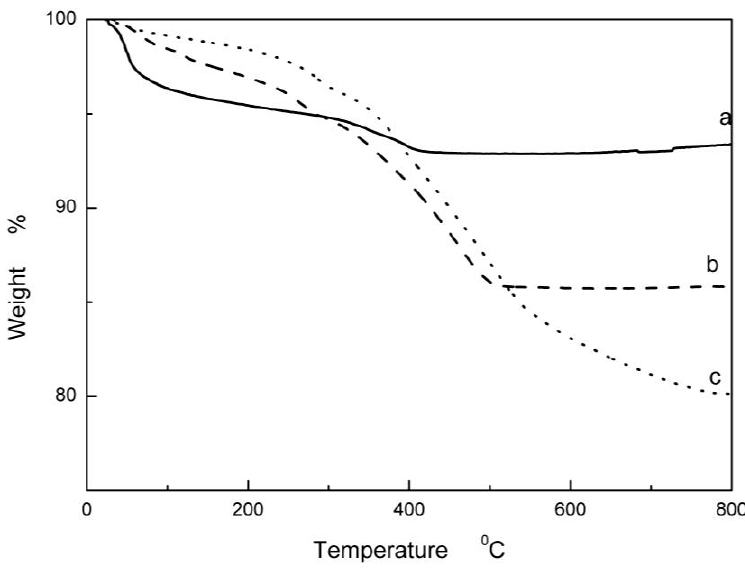
Figure 2. Thermogravimetric analysis (TGA) diagrams of the modified nano-ZnO particles,